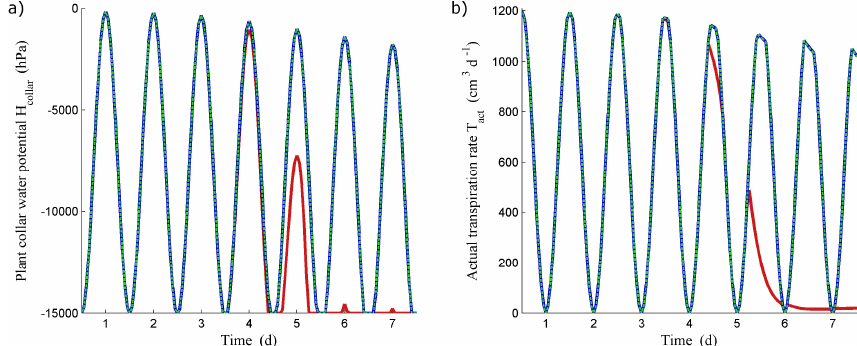
Fig. 10. Comparison of both explicit and implicit models predictions during the “Stress” scenario. (a) Plant collar water potential H collar predicted by the explicit model (blue solid line), by the implicit model (green dotted line) and by the implicit model when K comp =0 (red solid line). (b) Actual transpiration rate T act predicted by the explicit model (blue solid line), by the implicit model (green dotted line) and by the implicit model when K comp =0 (red solid line).